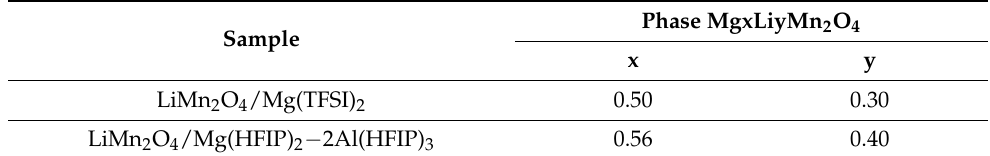
Table 1. Ratio between Mn, Mg, and Li after 5th charge in two non-aqueous electrolytes. Mole ratio of Mg and Li was normalized on